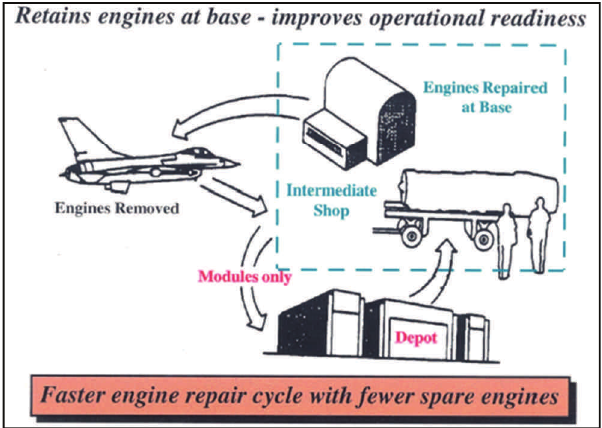
Fig. 2. Engine maintenance concept model